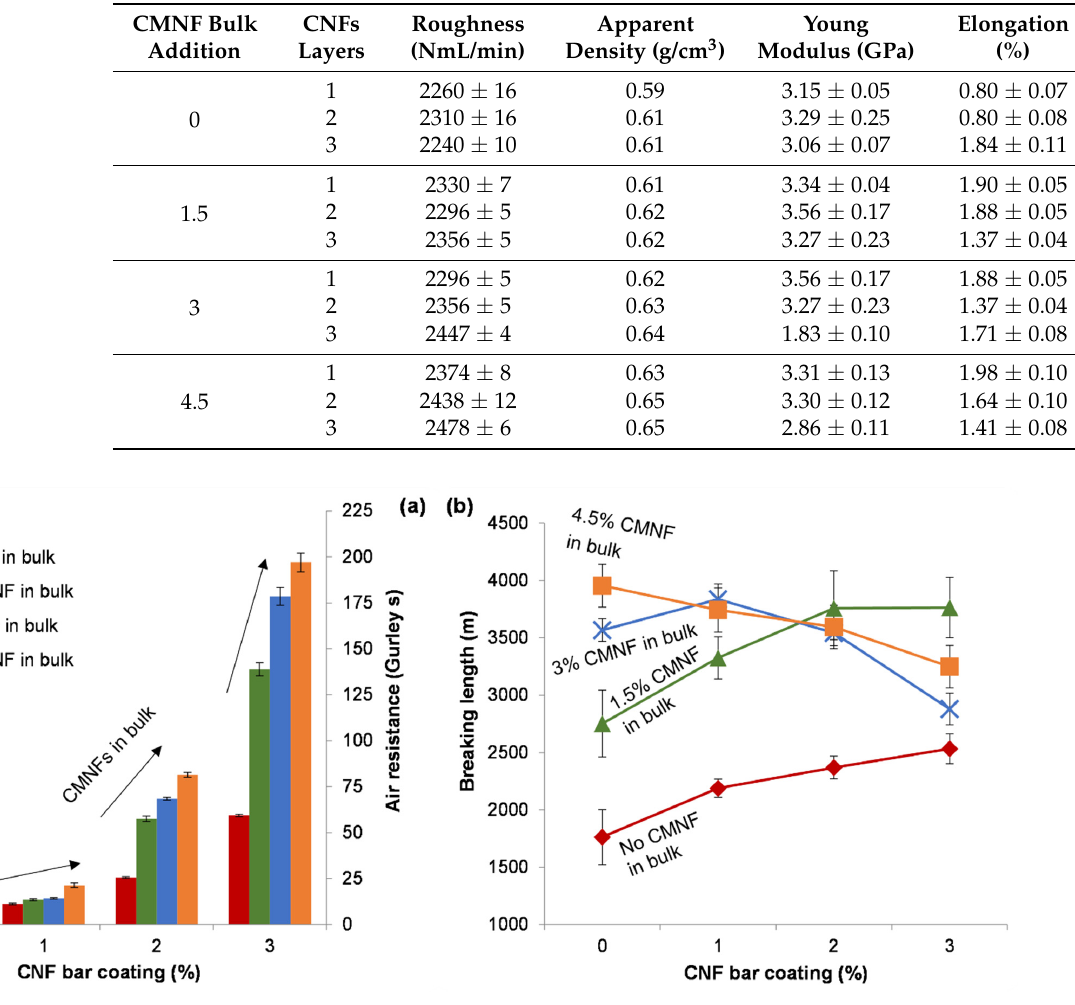
Figure 5. Evolution of air resistance ( a ) and breaking length ( b ) with the concentration of oxycellulose nanofibers in the coating suspension (bar coating), for the four levels of enzymatic CMNF content in bulk. Error bars correspond to twice the standard deviation.